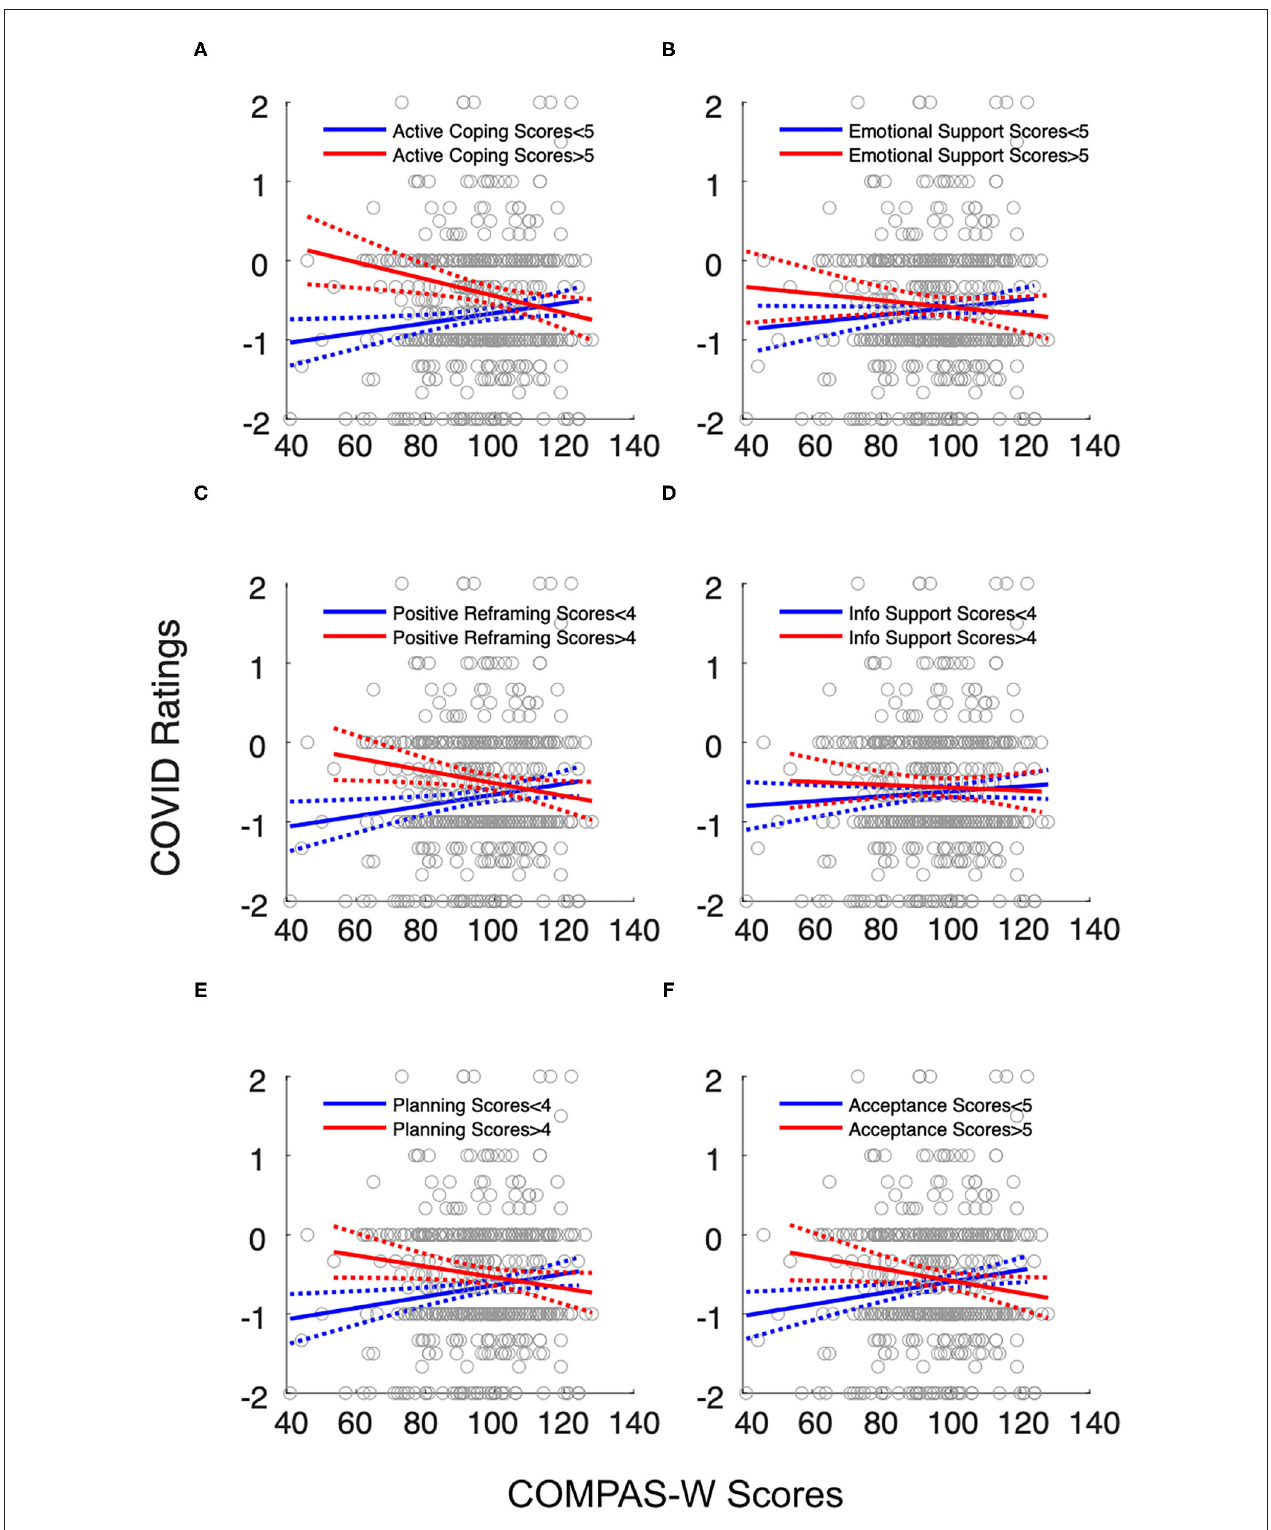
FIGURE 2 | The effect of well-being and specific Approach coping strategies on the impact of COVID isolation on male participants. The blue lines are the least-square regression fits for coping scores below the sample median. The red lines are the least-square regression fits for coping scores above the